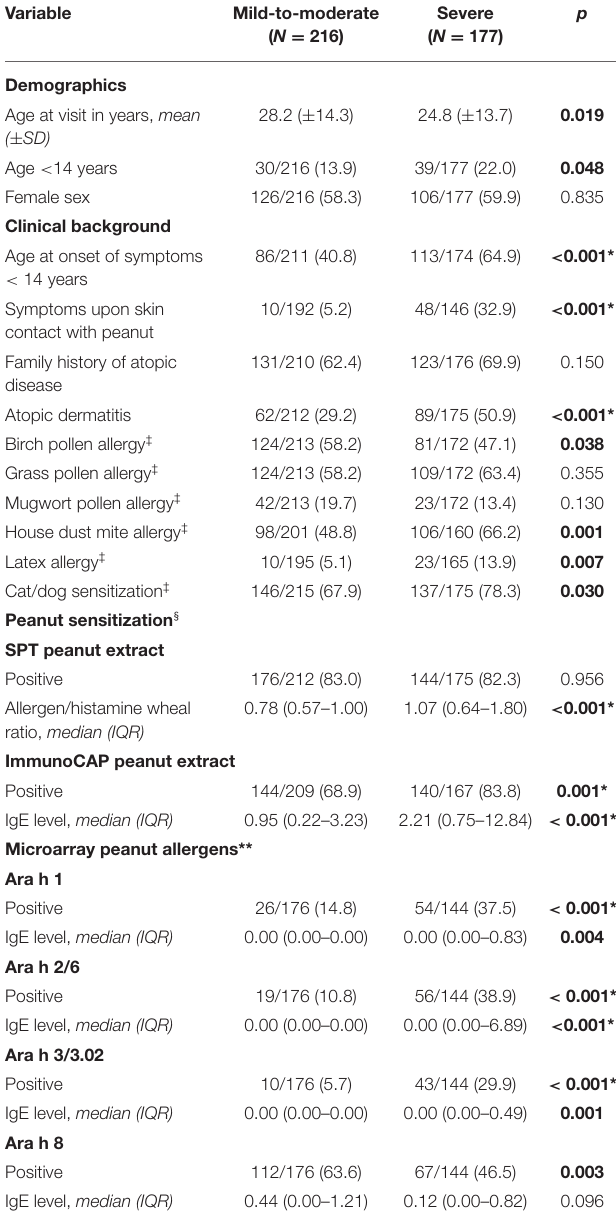
TABLE 1 | Characteristics of subjects with probable